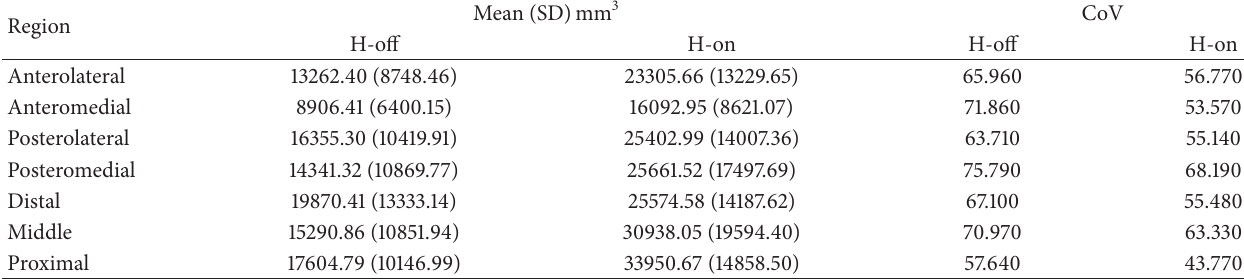
Table 6: Mean, standard deviation, and CoV (%) for regional intra cast shape difference of Hands-off and Hands-on methods. Region